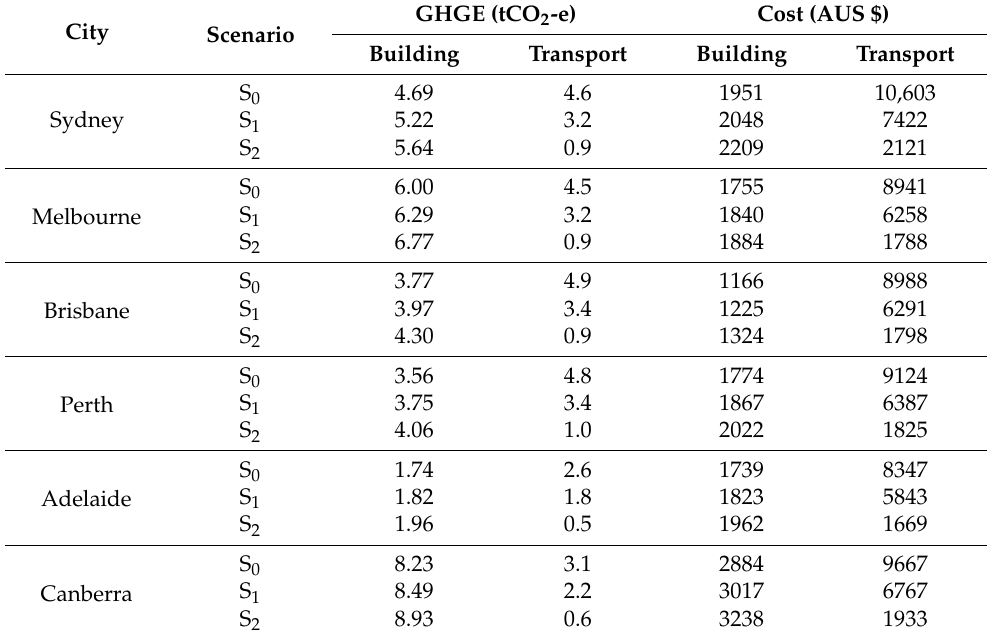
Table 4. Annual building and transport-related GHGE and cost per